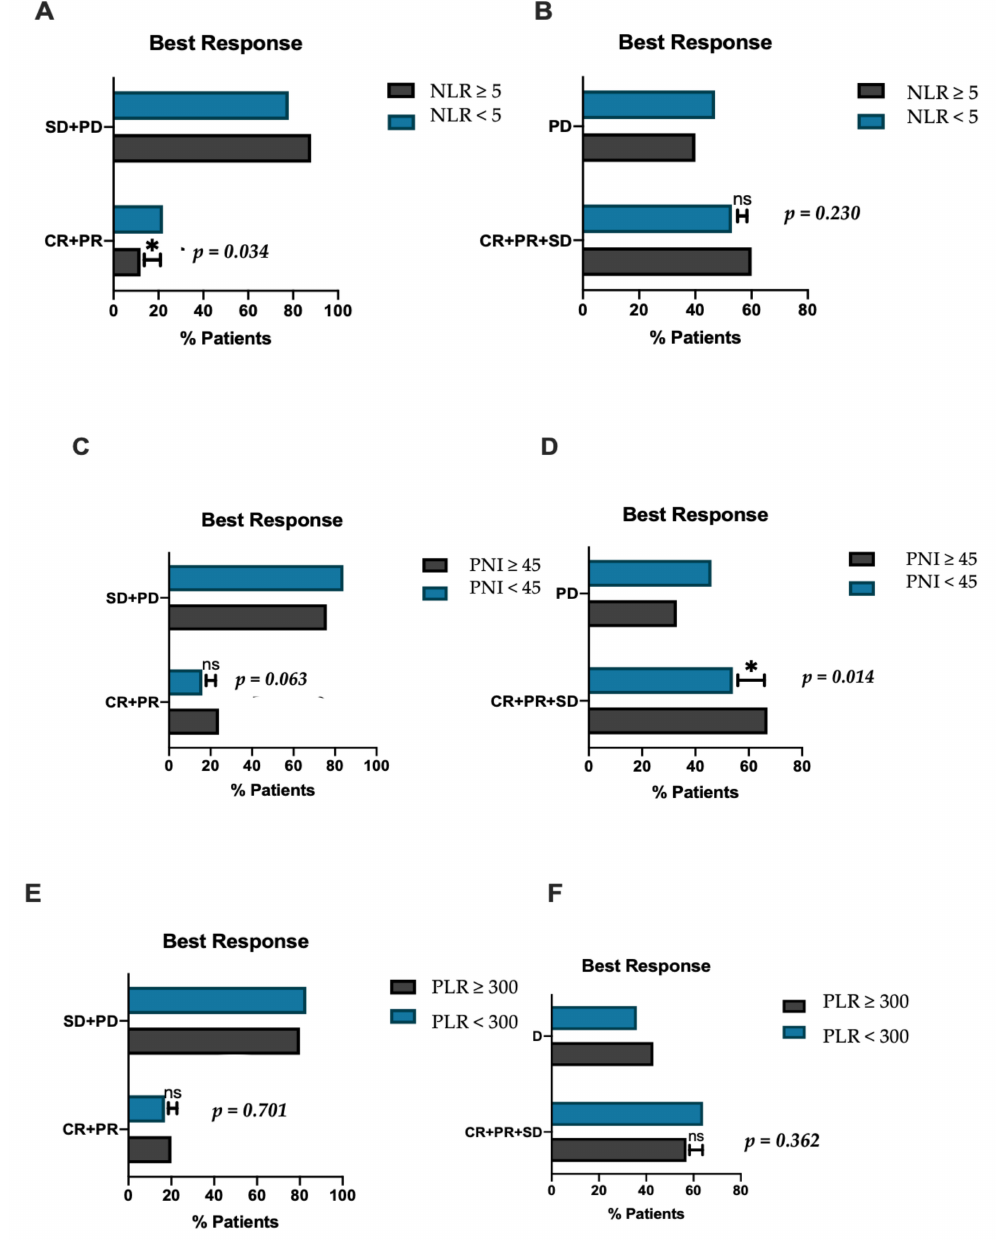
correlated with worse DCR compared to PNI ≥ 45 (52% vs. 66%, p = 0.014) (Figure 3D) and showed a trend toward worse ORR (24% vs. 16%, p = 0.063) (Figure 3C); no statistical difference in terms of DCR was observed in NLR high vs. NLR low patients (60% vs. 53%, p = 0.230) (Figure 3B) and in ORR or DCR according to PLR status (Figure 3D,F).